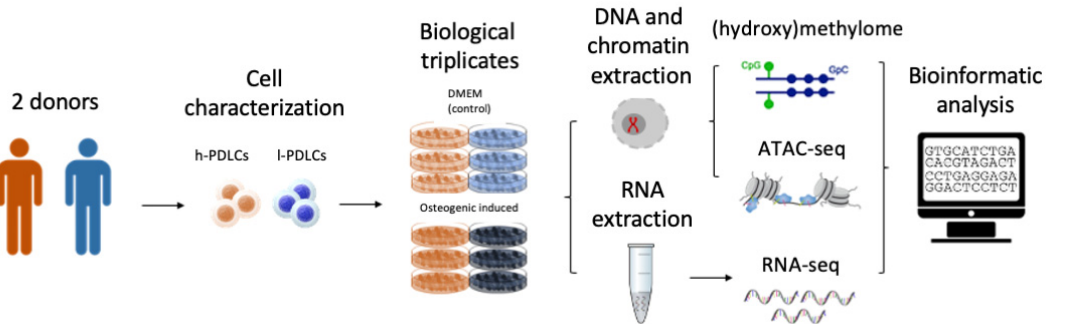
Figure 1. Experimental design. Periodontal ligament cells (PDLCs) were isolated from two differ- ent donors and characterized into populations with high osteogenic potential (h-PDLCs) and low osteogenic potential (l-PDLCs) (Assis et al. [5,8]). Three independent experiments were performed for each population where the cells were cultured for 10 days either in standard culture media (DMEM) or in osteogenic media (OM) to promote activation of the pro-osteogenic programme. DNA, chromatin and RNA were collected to perform DNA (hydroxy)methylome (Infinium Methylation EPIC BeadChip (Illumina) assay), Assay for Transposase to Accessible Chromatin (ATAC-seq) and transcriptome (RNA-seq) analysis, respectively.